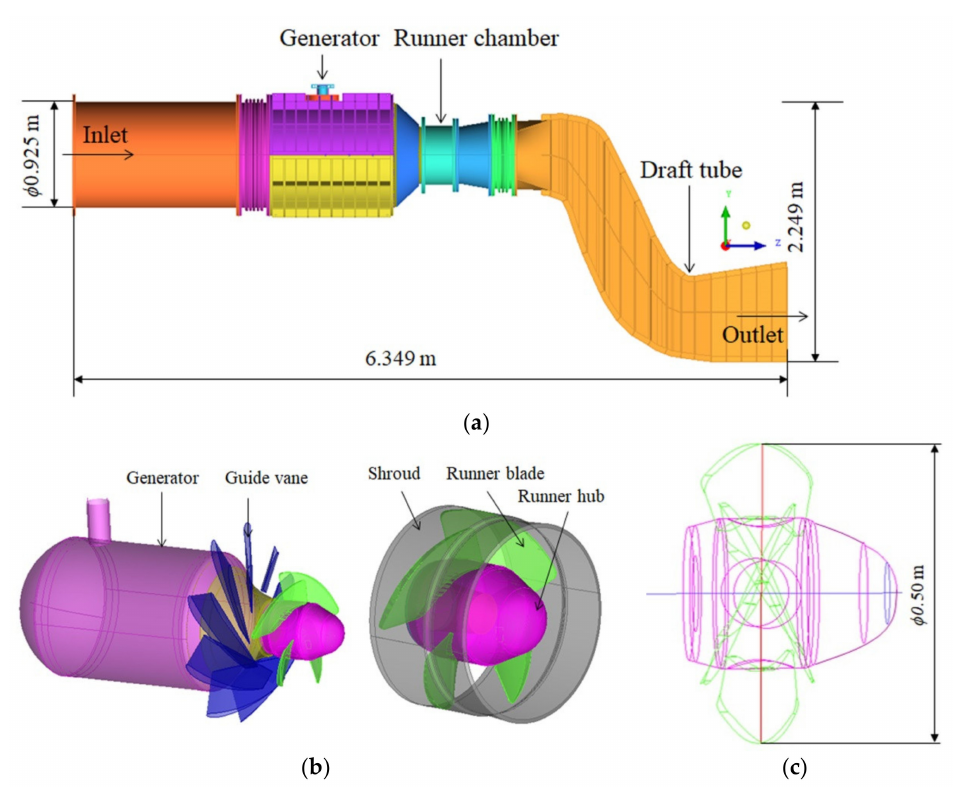
Figure 5. Three dimensional (3D) geometry of a propeller type turbine: ( a ) turbine; ( b ) generator, runner, and guide vane; ( c ) dimension of